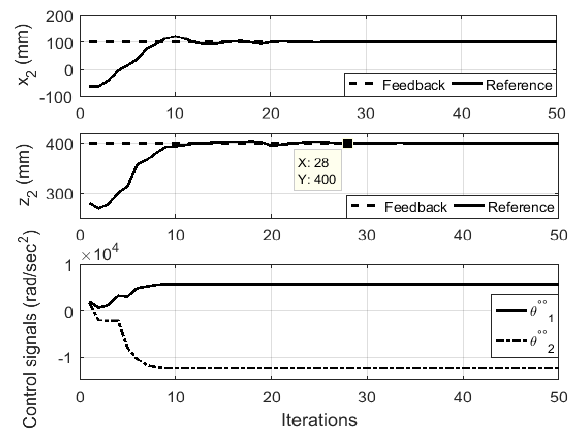
Figure 5. Results of set-point simulation to evaluate the stabilization of the controller with the dynamic model